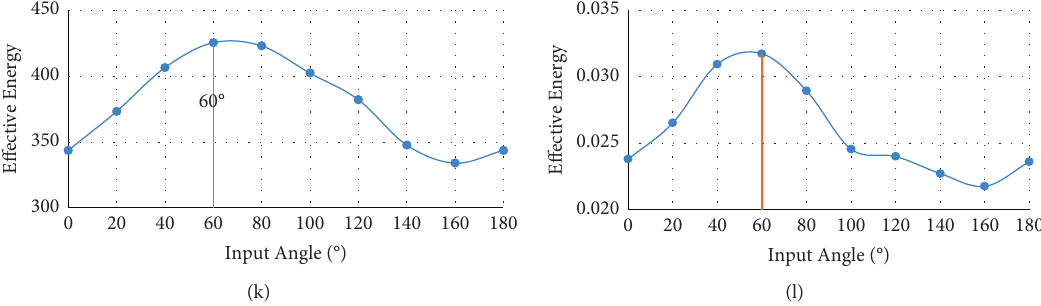
Figure 5: The effective input energy and top displacement of structure A, structure B, and structure C under imperial valley-06 at different input angles. (a) The effective input energy in the X -direction of structure A. (b) The effective input energy in the X -direction of structure B. (c) The effective input energy in the X -direction of structure C. (d) The effective input energy in the Y -direction of structure A. (e) The effective input energy in the Y -direction of structure B. (f) The effective input energy in the Y -direction of structure C. (g) The top displacement in the X -direction of structure A. (h) The top displacement in the X -direction of structure B. (i) The top displacement in the X - direction of structure C. (j) The top displacement in the Y -direction of structure A. (k) The top displacement in the Y -direction of structure B. (l) The top displacement in the Y -direction of structure